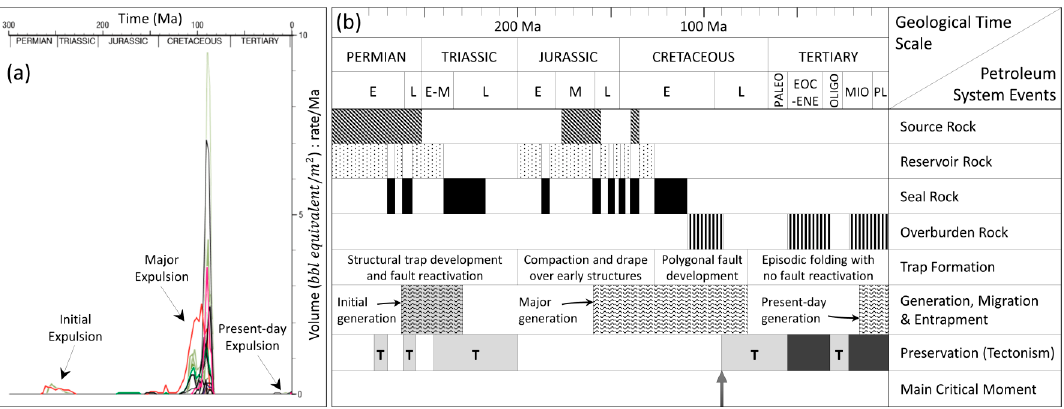
Figure 4. Summary of the Cooper-Eromanga Petroleum System Events: ( a )—The timing of hydrocarbon generation and expulsion through time showing that initial expulsion commenced in the Late Permian and continues today [50]; ( b ) A summary of the key petroleum system events in the Cooper-Eromanga Petroleum System [30].